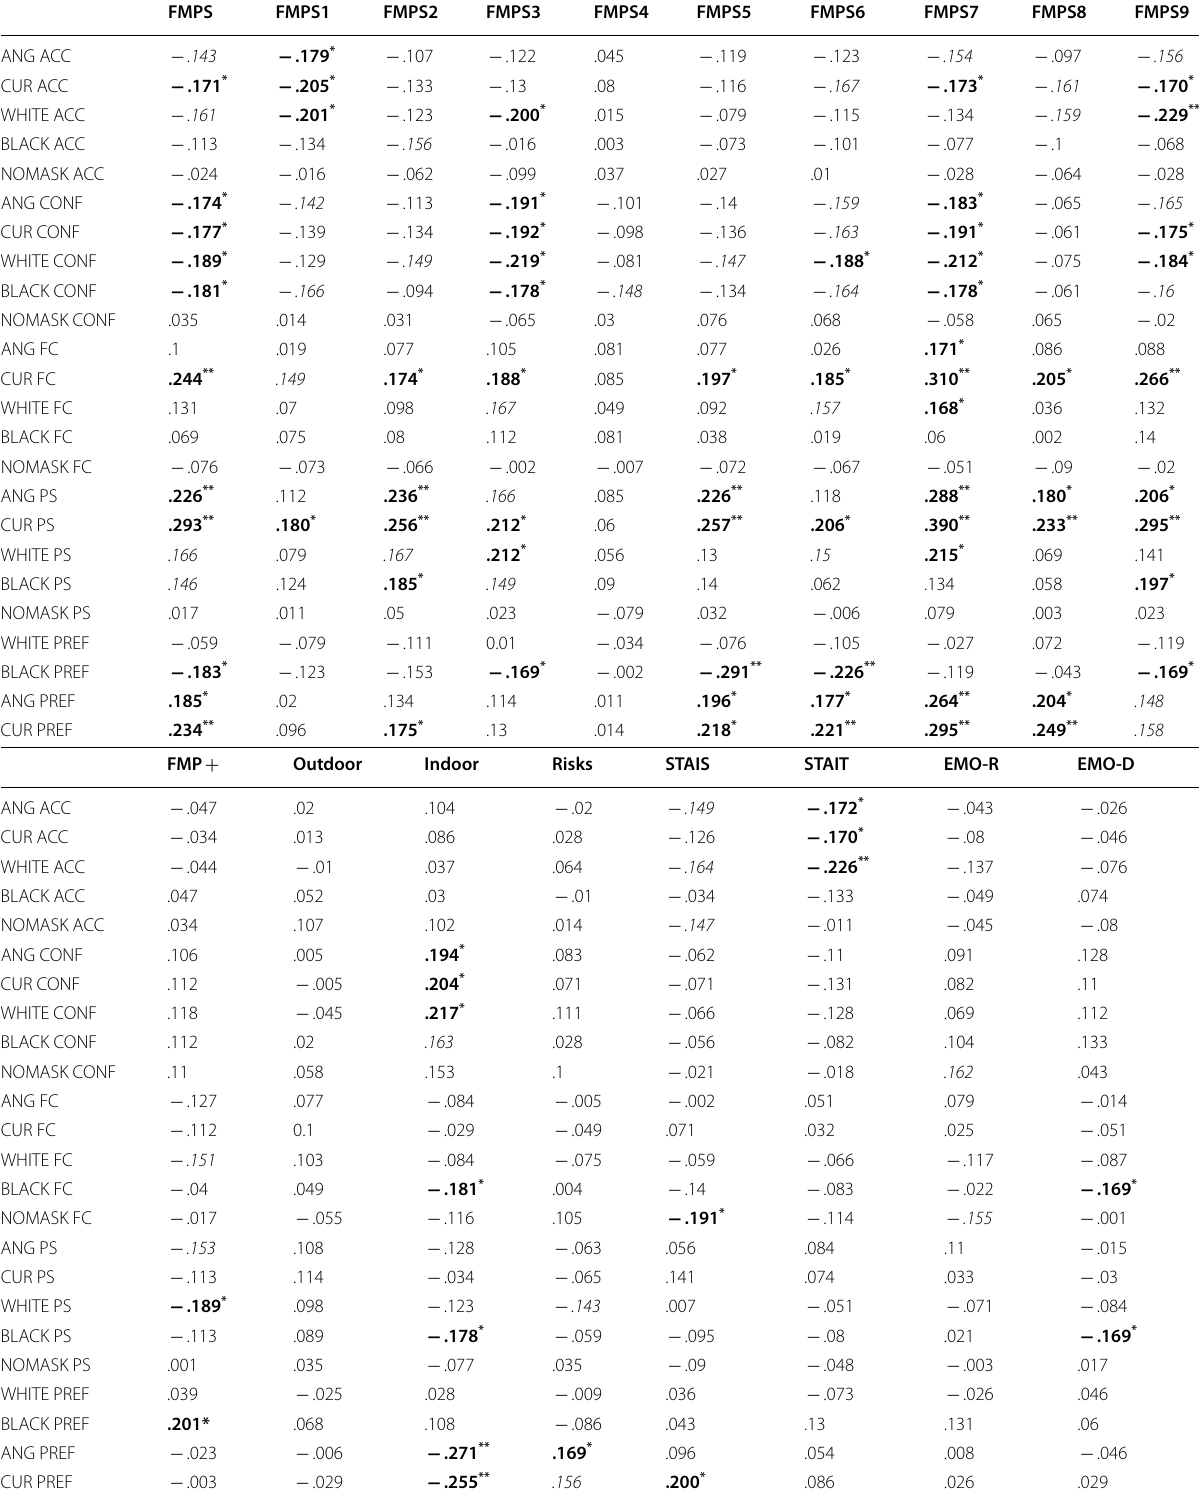
Table 2 Correlations between emotion recognition and individual differences self‑reports